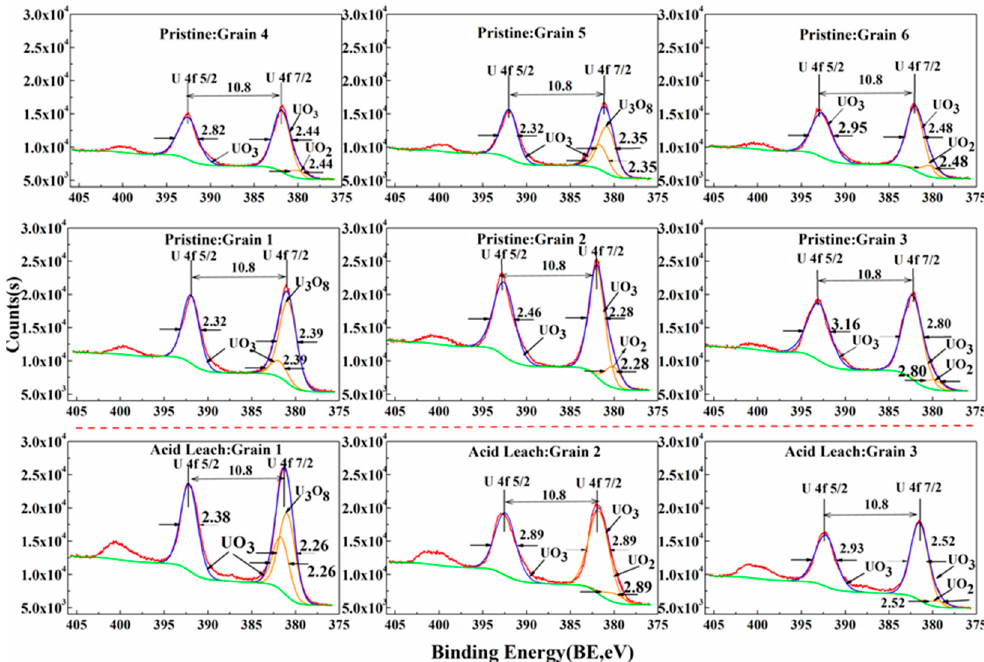
Figure 9. XPS narrow scans of uranium in the MHK uranium deposit. Above the red dotted line: pristine samples; below the red dotted line: samples leached by sulfuric acid. The red lines, blue lines, orange lines and green lines were original spectrogram, fitting spectrogram, peak fitting curves of di ff erent uranium chemical valences and baseline,